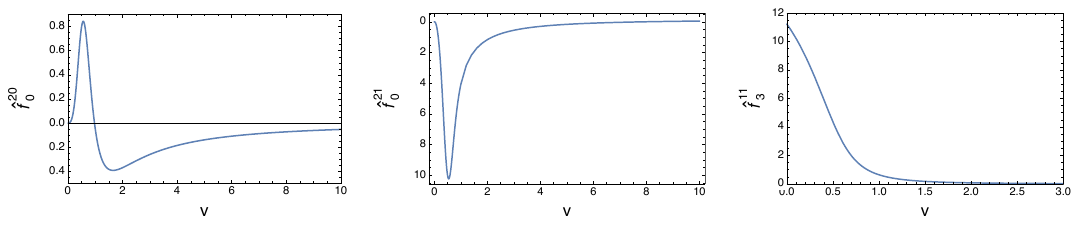
, ^ f 11 and ^ f 21 that appear in the expansion 0 3 0